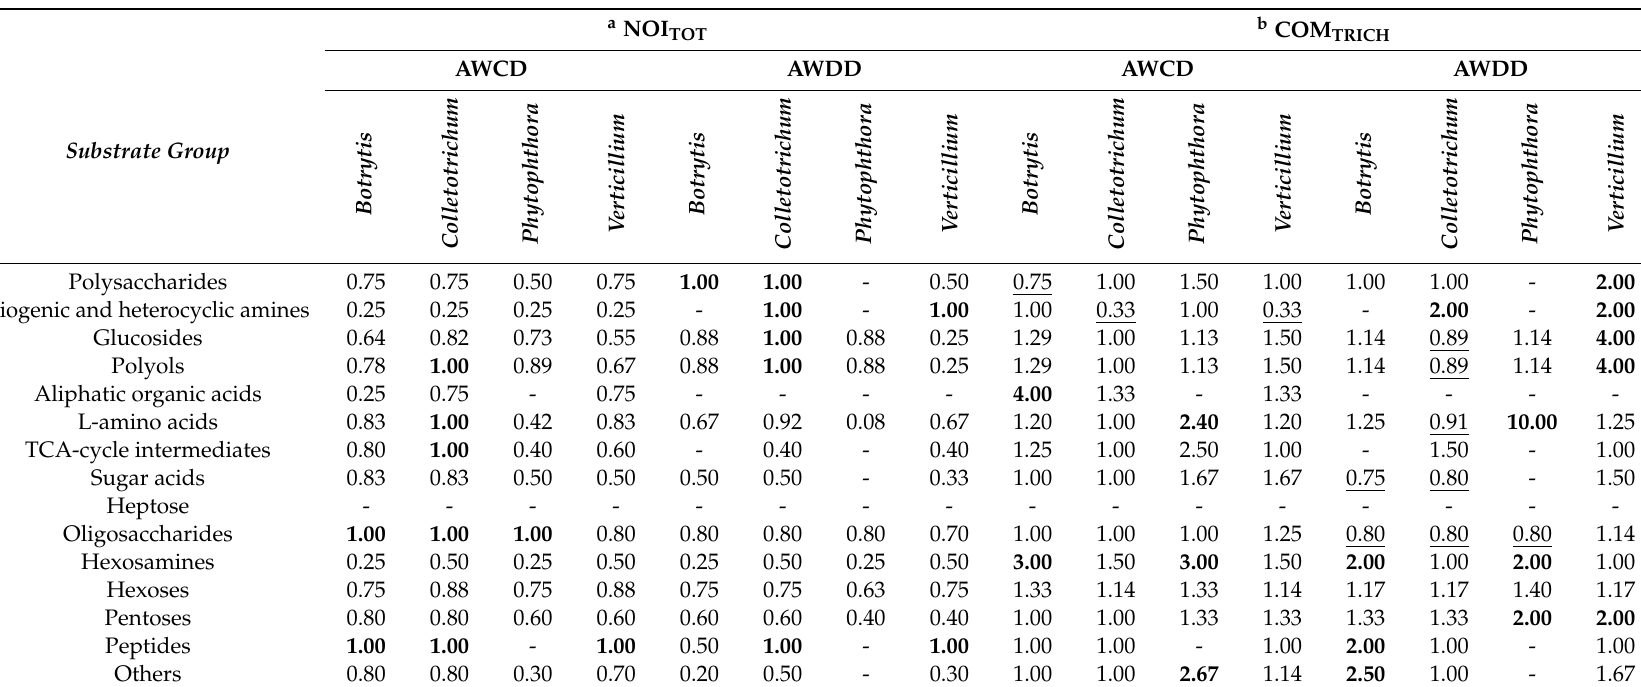
Table 3. Total Niche Overlap Index (NOI TOT ) and Trichoderma Competitiveness Index (COM TRICH ). The presented indices were calculated on the basis of